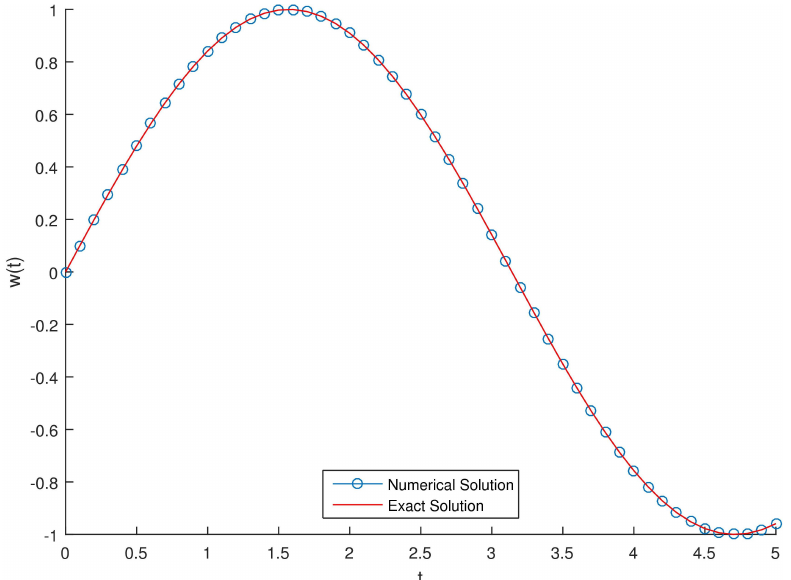
Figure 19. The compared results of the approximate and exact solutions for Example 6 when c = 1/10 in the interval t ∈ [ 0,5 ] .